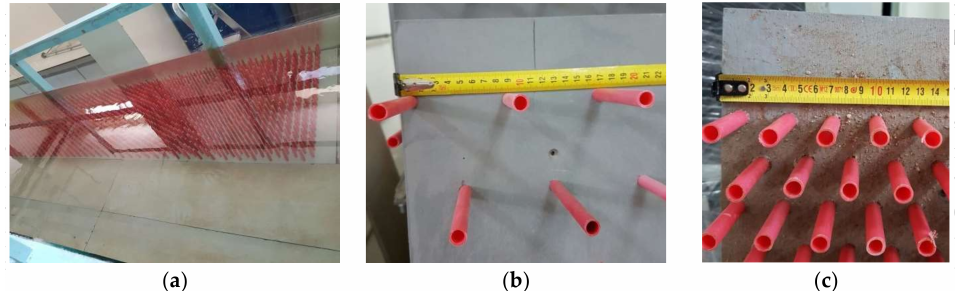
Figure 3. Photos from experimental set-up: ( a ) Vegetation layer in the flume; ( b ) vegetation layer with φ 1 = 0.01; ( c ) vegetation layer with